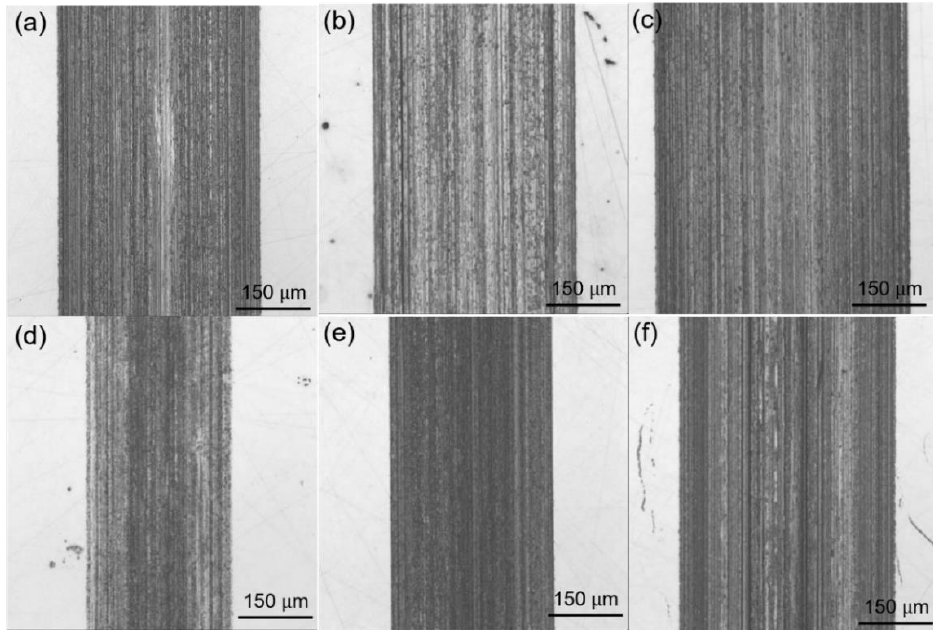
Figure 8. Optical microscope images of wear tracks at different temperature (150 N): base grease at 80 ◦ C ( a ), 150 ◦ C ( b ) and 175 ◦ C ( c ); modified talc-based grease at 80 ◦ C ( d ), 150 ◦ C ( e ) and 175 ◦ C ( f ).